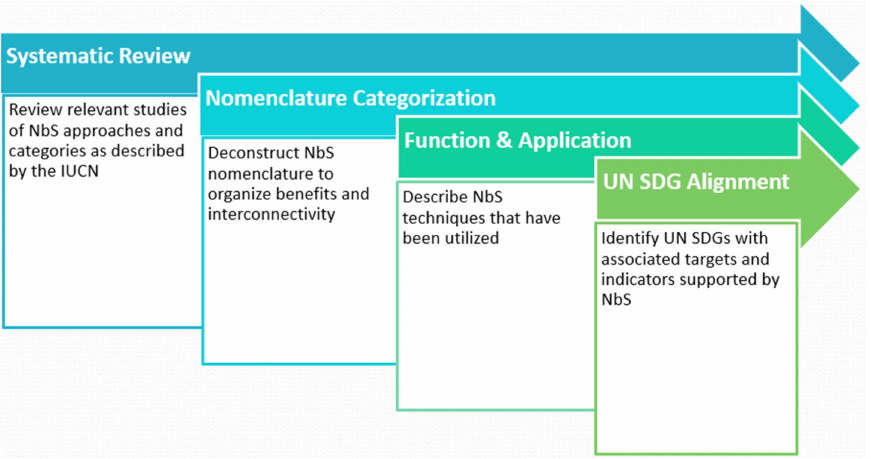
Figure 1. Methodological pathway including four specific steps that use IUCN categories to organize and characterize NbS and culminate in their alignment and connection with the UN